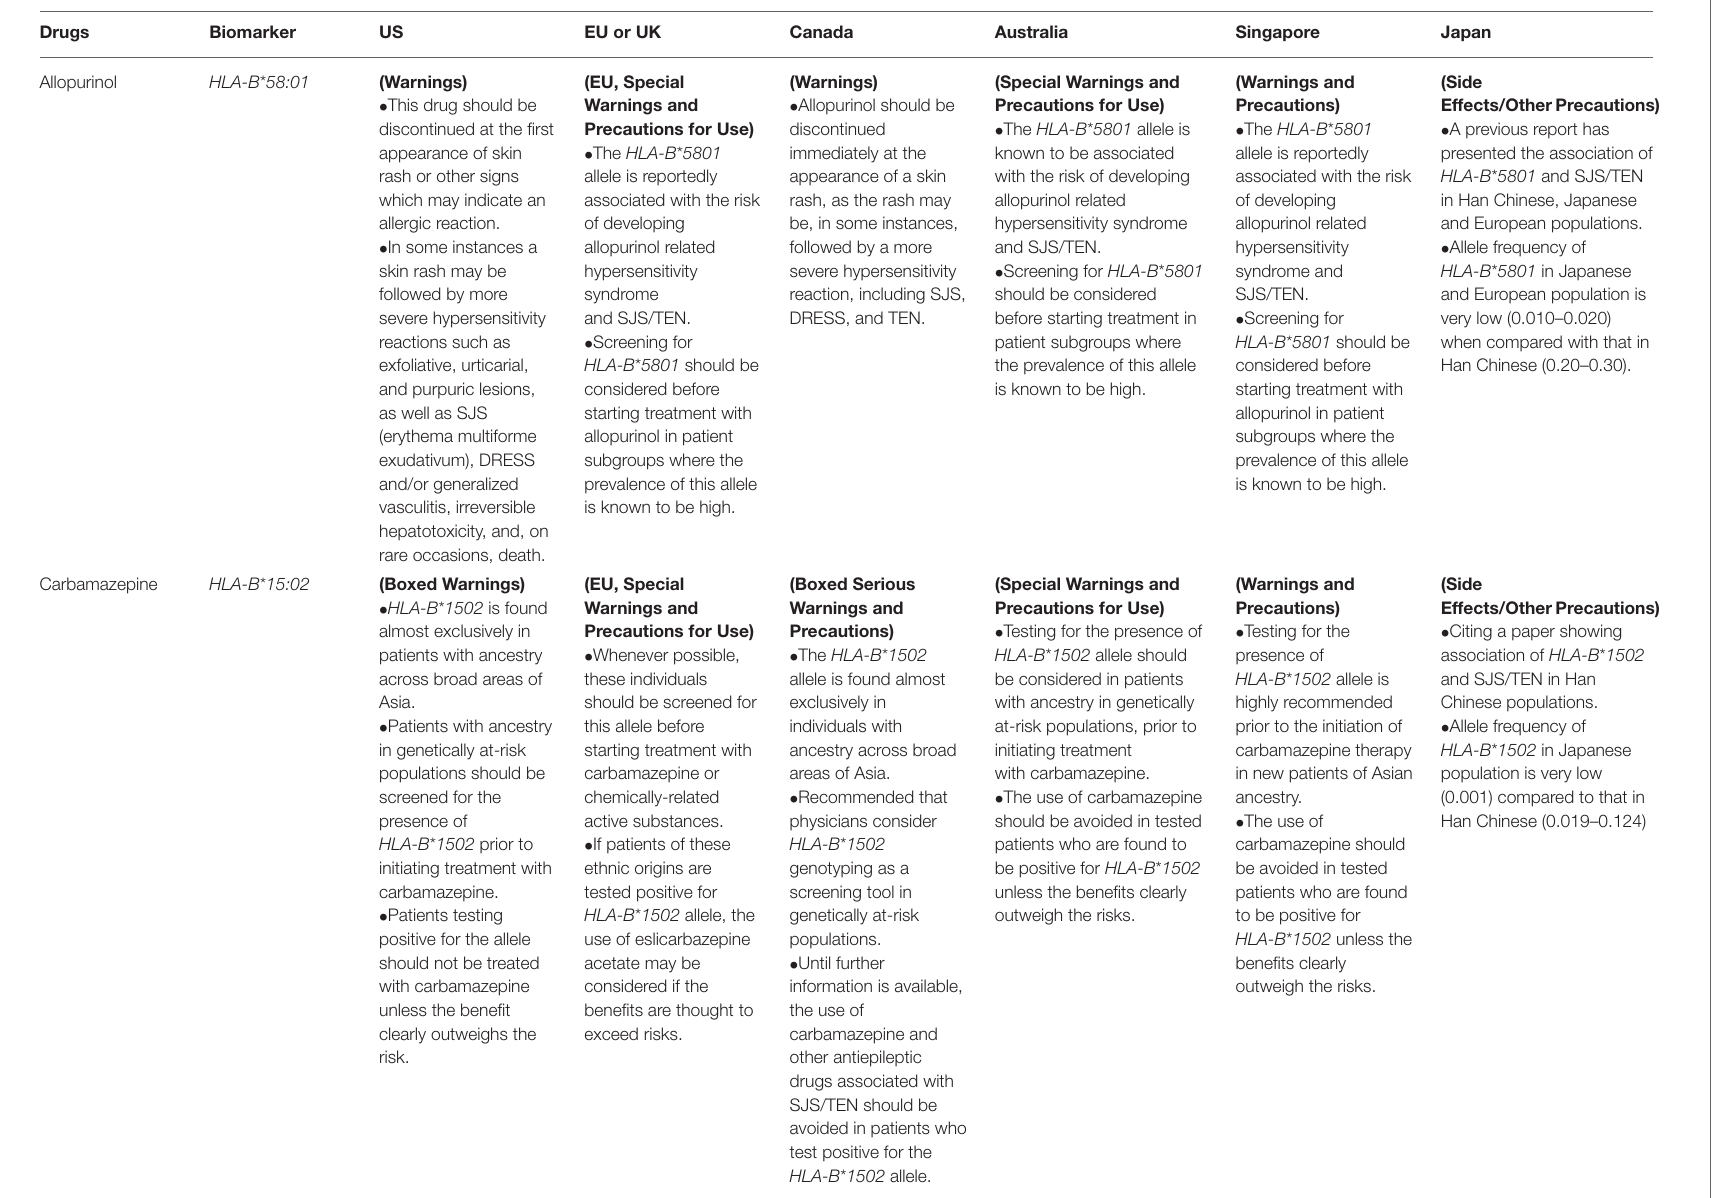
TABLE 1 | Description of pharmacogenomic information in the five drug labels of the United States, European Union (EU) or the United Kingdom (UK), Canada, Australia, Singapore, and Japan.